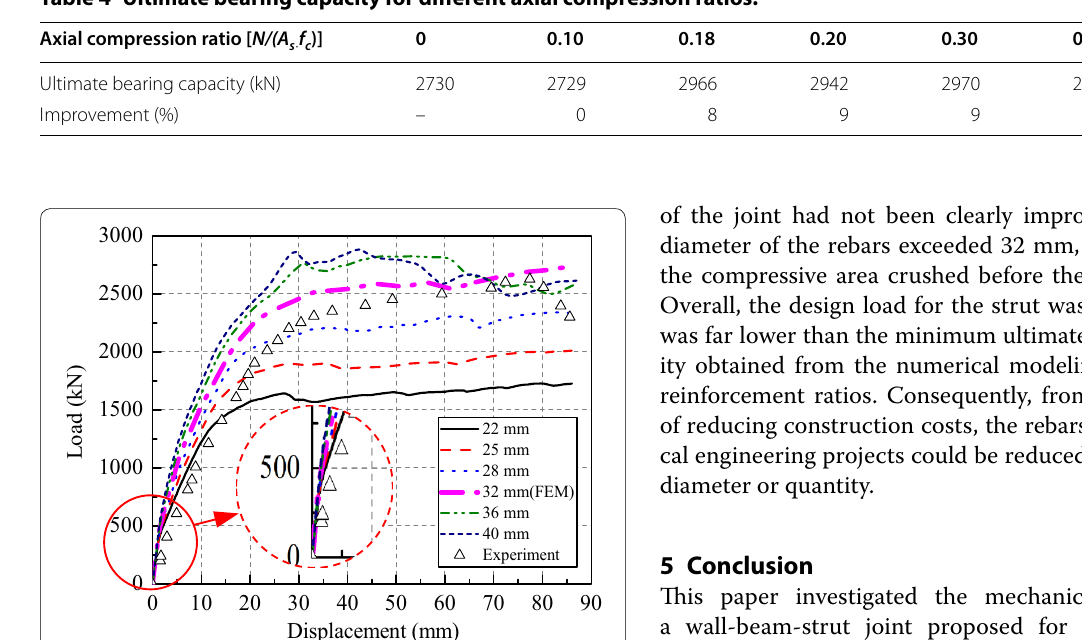
Table 4 Ultimate bearing capacity for different axial compression ratios.